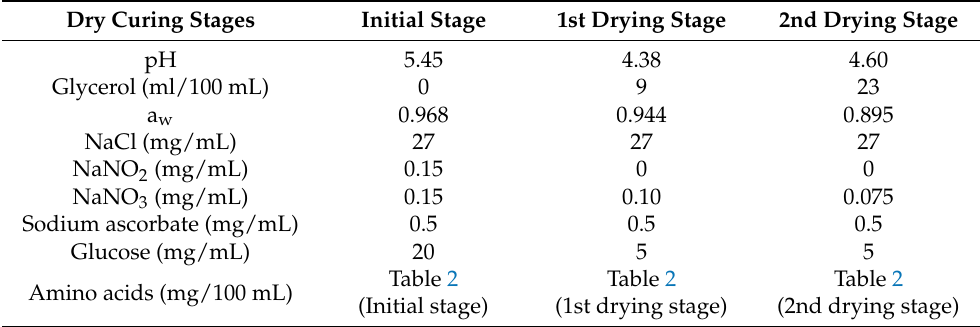
Table 3. Physicochemical conditions of the model systems simulating the ripening stages in the production of dry fermented sausages.